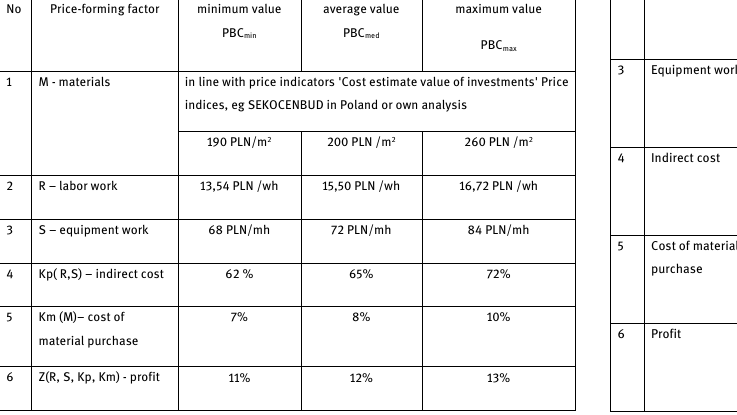
Table 1: Comparison of minimum, average and maximum price Price-forming factor